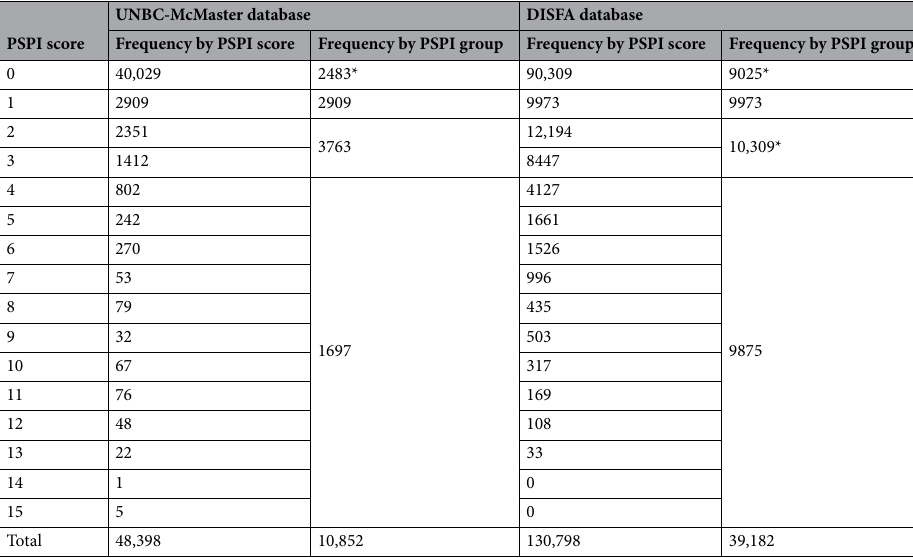
Table 5. Frequency distribution of video frames in the UNBC-McMaster and DISFA databases by PSPI scores and PSPI groups. *Random under-sampling of over-represented PSPI groups was performed to create more balanced study datasets with smaller total numbers of video frames for training and testing the pain intensity classification